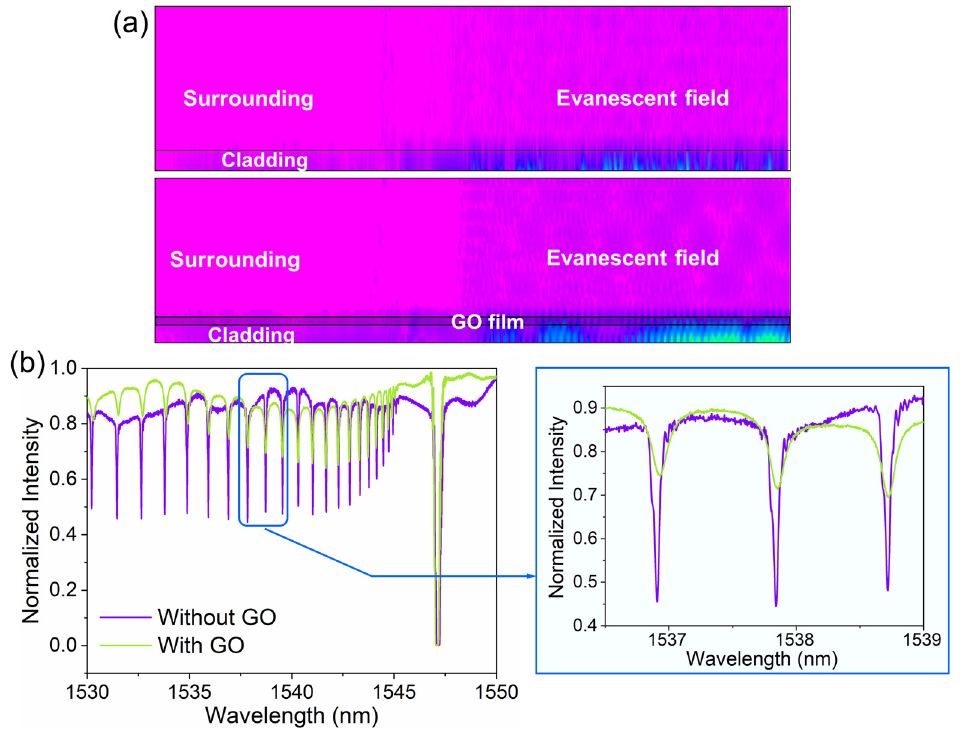
Figure 7. ( a ) The simulated optical field on the cladding surface of the FBG before and after GO- coating. ( b ) The comparison in the transmission spectrum of the FBG sensor before and after coating.